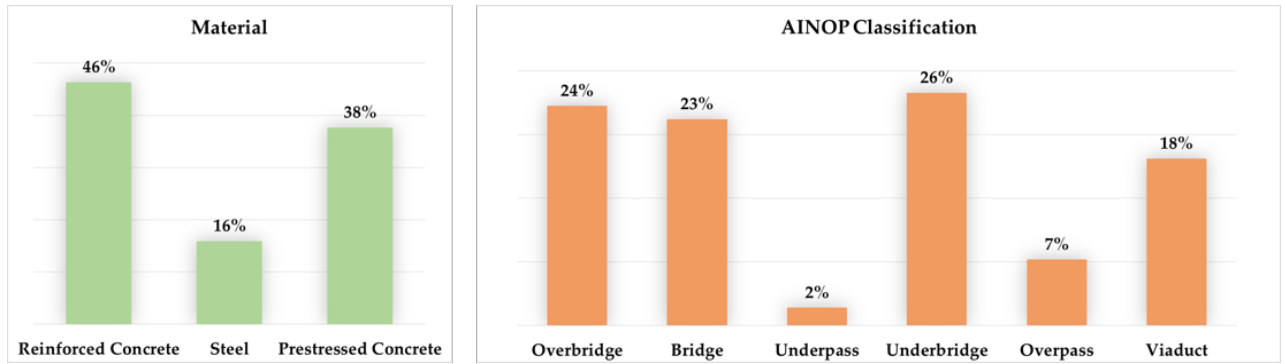
Figure 2. Bridges and viaducts (red circle) on the A3 highway (blue line).